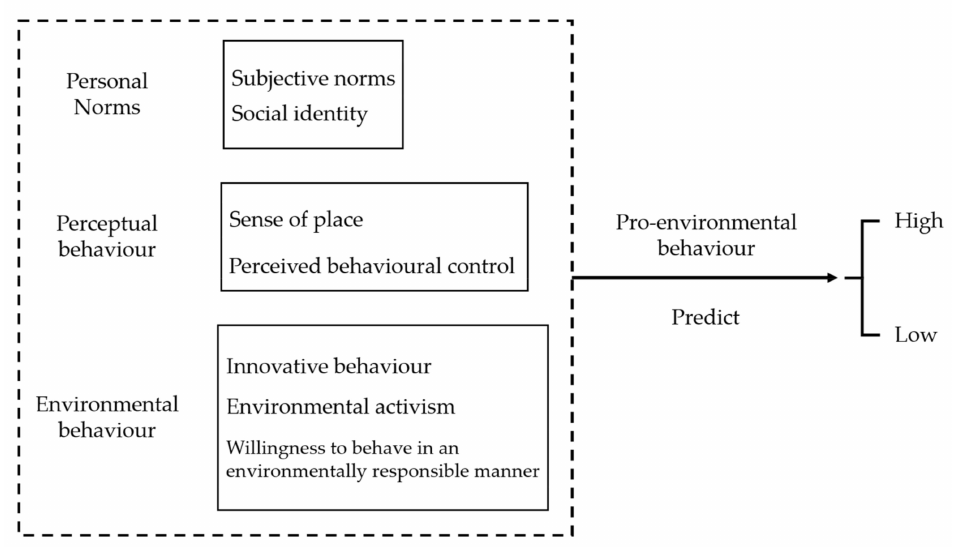
Figure 1. Hypothetical predictions of pro-environmental